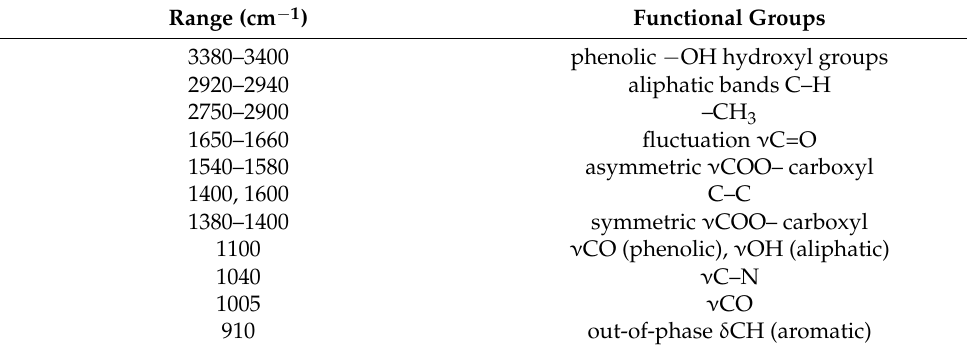
Figure 3. IR spectra of humic acids, hydroxypropyl methylcellulose, and hydroxypropyl methylcellulose– humic acids system: 1 — hydroxypropyl methylcellulose; 2 — humic acids; 3 — hydroxypropyl methylcellulose +5% wt. humic acids, 4: hydroxypropyl methylcellulose +10% wt. humic acids. Table 2. IR spectral characteristics of humic acids, hydroxypropyl methylcellulose, and hydroxypropyl methylcellulose–humic acids system.